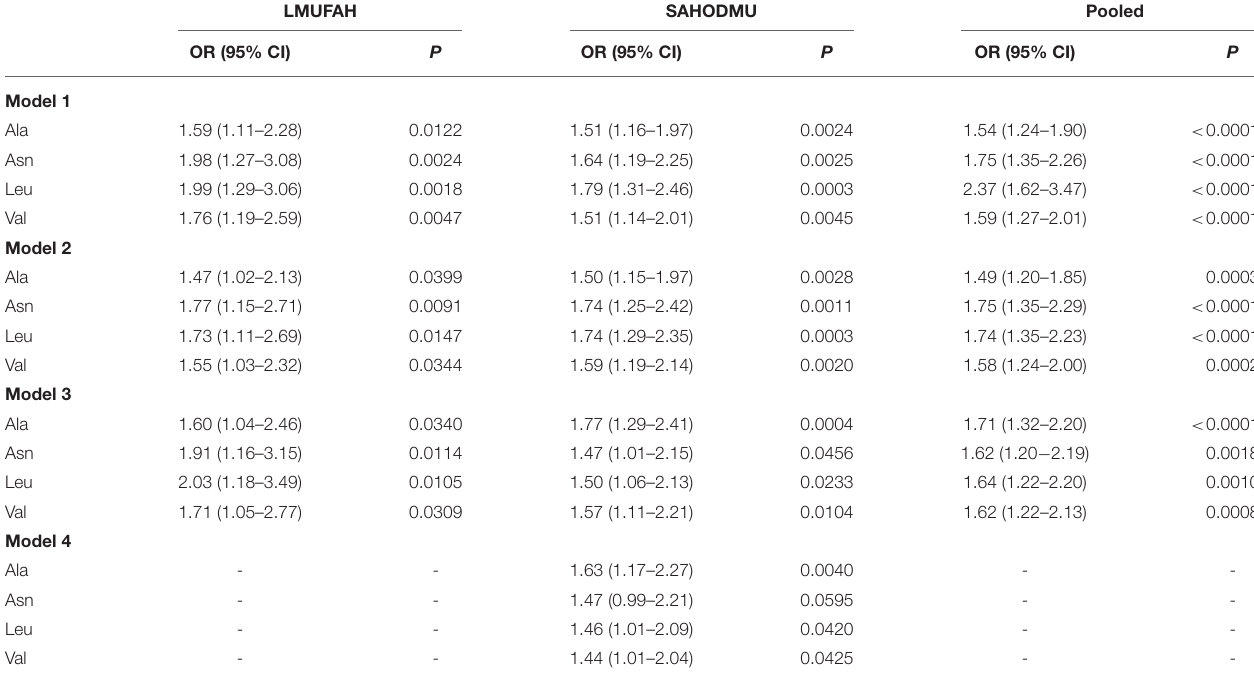
TABLE 3 | Associations between amino acids and hypertriglyceridemia in two cohorts. LMUFAH SAHODMU